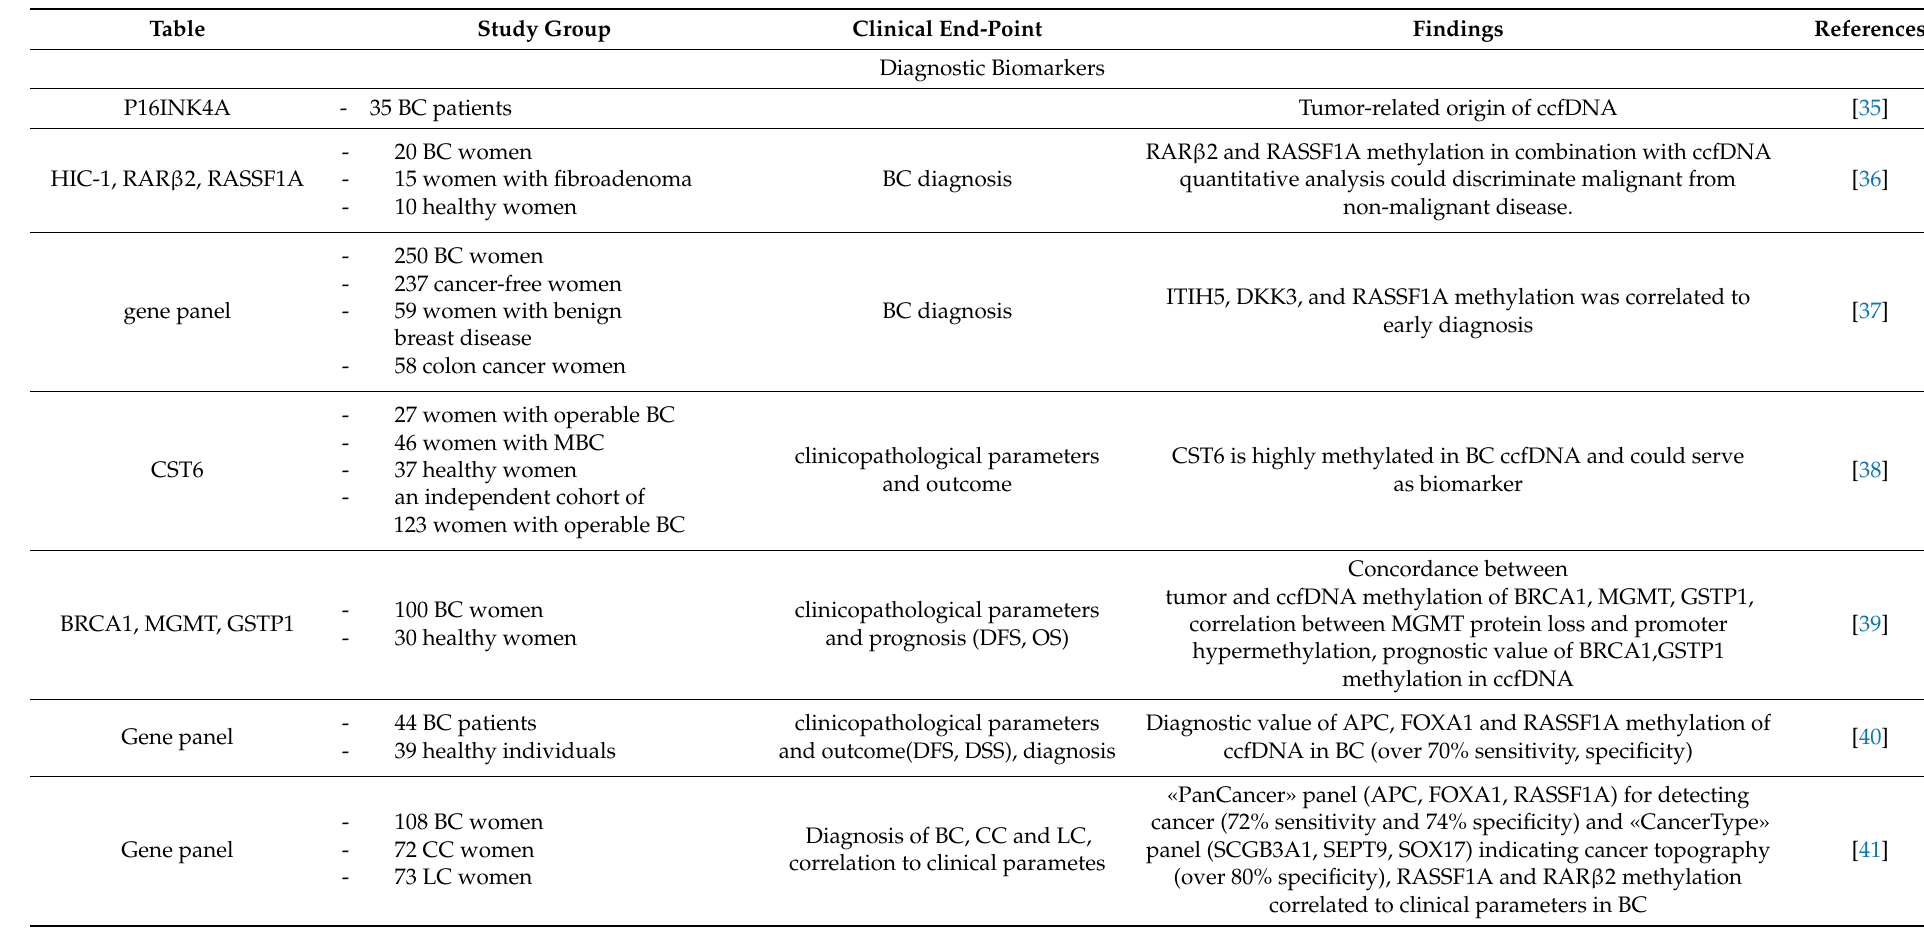
Table 1. Summary of studies evaluating ccfDNA methylation in BC diagnosis, prognosis and treatment response. Table Study